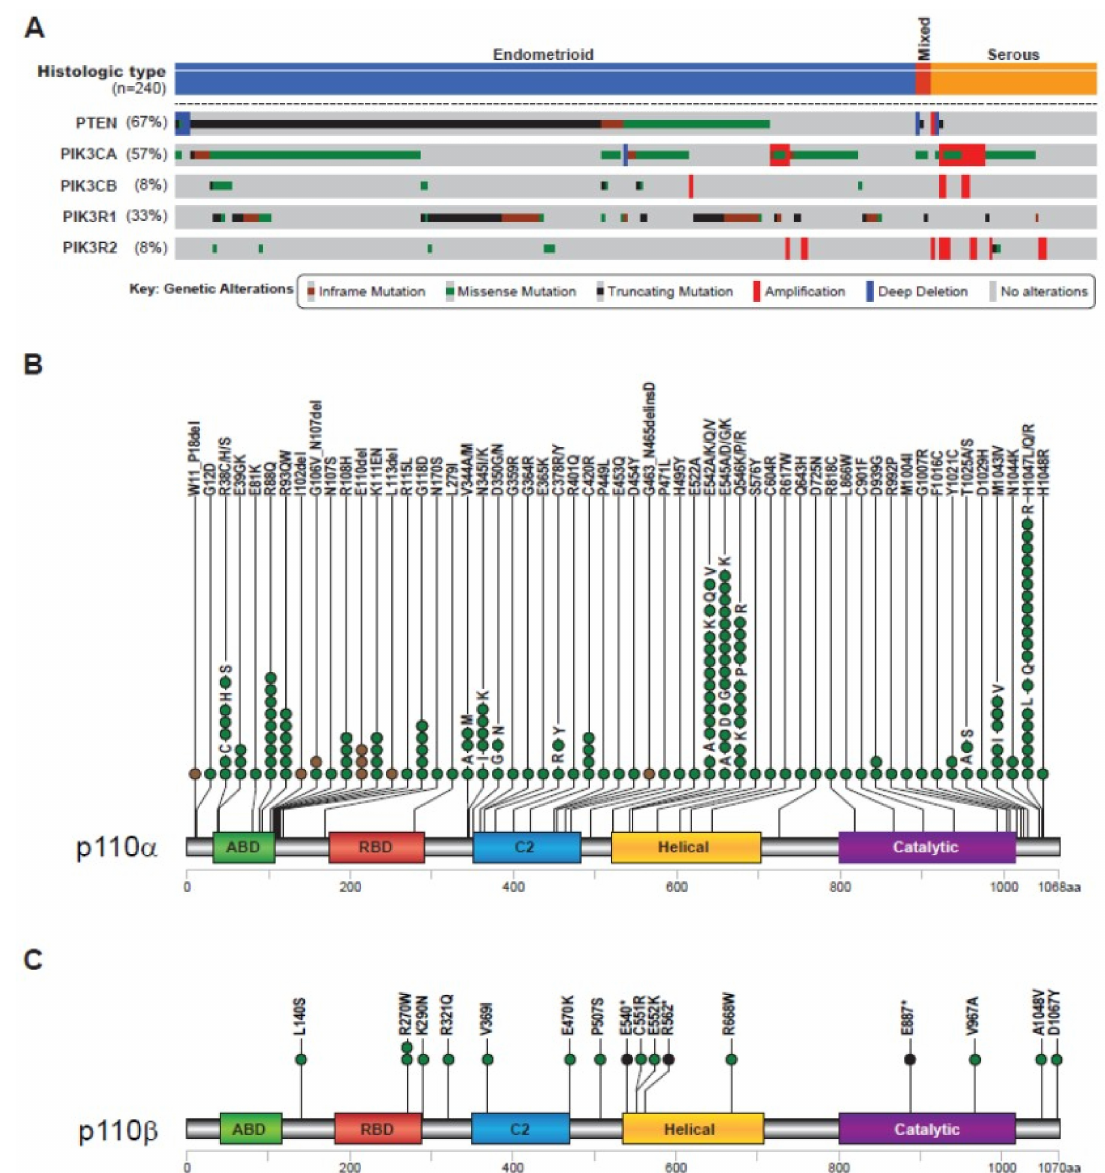
Figure 4. Overview of genomic alterations in PI3K pathway genes in endometrial cancer. ( A ) Overview of alterations in selected PI3K pathway genes in endometrial cancer, showing mutations and copy-number alterations, as well as the frequency of alterations. ( B ) Overview of mutations in PIK3CA displayed on the p110 α protein structure. Note the hotspot mutational sites in p.E524, p.E545, p.Q546 and p.H1047, i.e., those with the highest number of lesions and the corresponding mutation. ( C ) Overview of mutations in PIK3CB displayed on the p110 β protein structure by amino acid position. Panels were generated using the cBioPortal [94,95] with modifications with data from The Cancer Genome Atlas (TCGA) from a total of 240 patients with endometrial cancer [88]. Each dot corresponds to the occurrence of a specific mutation in a lesion. Mutations in ( B ) and ( C ) are colour-coded according to the key shown in ( A ) (green for missense mutations and brown for other in-frame mutations such as insertion and deletion). Abbreviations: ABD, adaptor binding domain; RBD, Ras-binding domain, C2; protein-kinase-C-homology-2 domain, Helical; helical domain, Catalytic; kinase